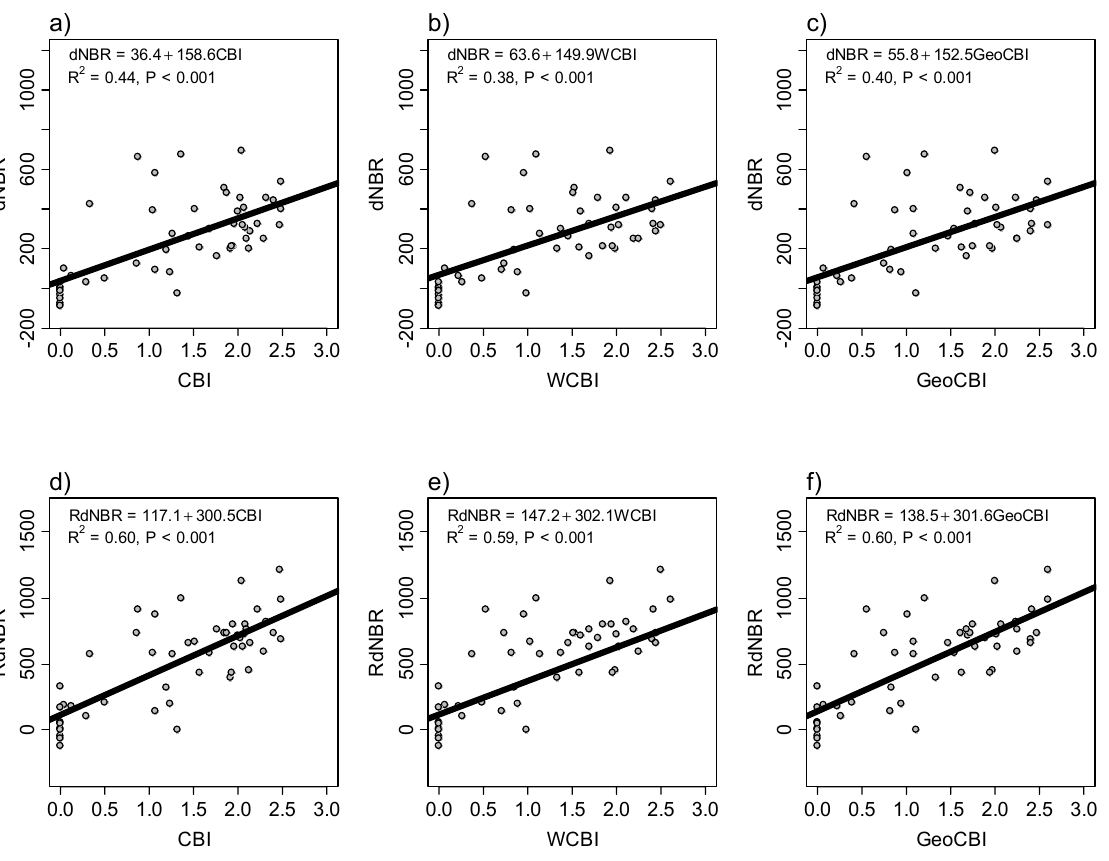
Figure 3. Linear regression models for the GeoCBI data set (n = 52) from the two fires measured after the GeoCBI was published in 2008. Models are for ( a ) dNBR and CBI, ( b ) dNBR and WCBI, ( c ) dNBR and GeoCBI, ( d ) RdNBR and CBI, ( e ) RdNBR and WCBI, and ( f ) RdNBR and